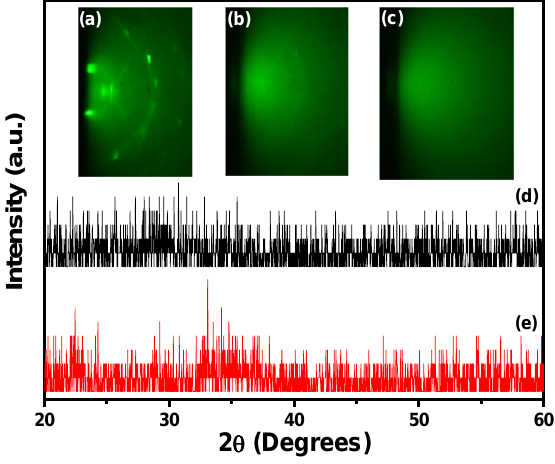
Figure 11. The in situ evolution of structure less RHEED patterns during LaGdO growth: ( a ) on Si (100) substrate; ( b ) after deposition by one laser ablation shot (layer thickness ~2 Å); ( c ) after completion of deposition (layer thickness: ~30 nm ) . The XRD spectra of amorphous LaGdO ultra-thin films of thicknesses ( d ) ~4 nm and ( e ) ~30 nm on 3 Si (100) substrates. Reproduced by permission of ECS–The Electrochemical Society [24].